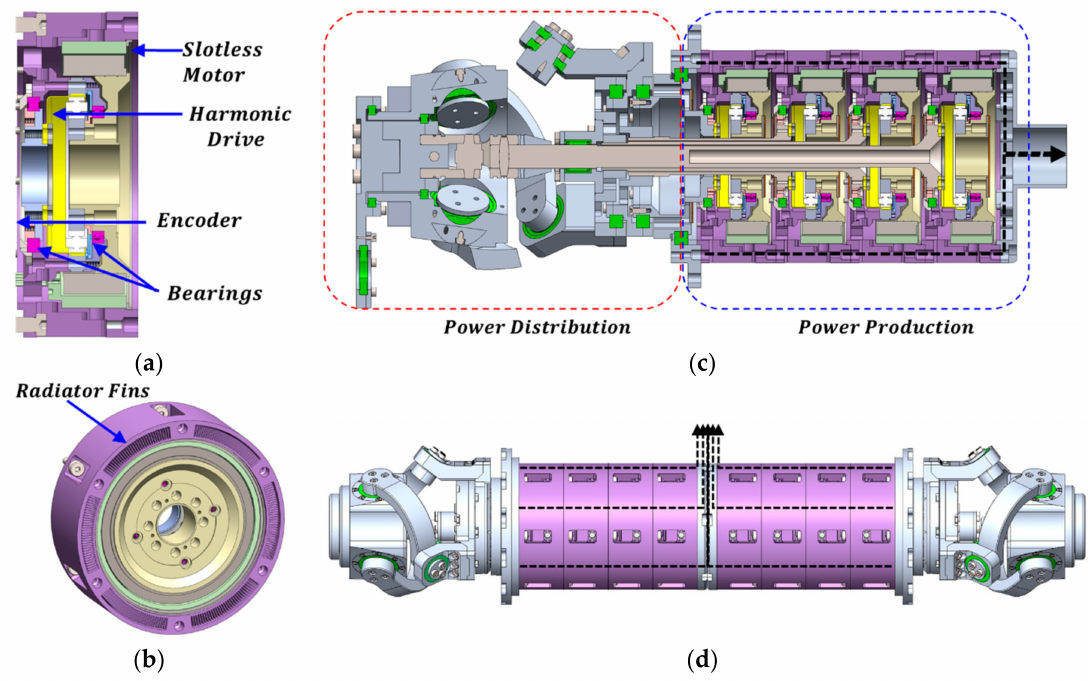
Figure 1. Design of the proposed actuator module; ( a ) Cross section of the proposed unit module; ( b ) Isometric view; ( c ) Cross section of a four-level concentrically stacked modular (4-CoSMo) actuator and the power output joint mechanism; ( d ) Application example of an eight-level concentrically stacked modular (8-CoSMo) actuator consisting of two 4-CoSMo actuators facing each other (dashed black arrows show the scheme of air flow in the proposed